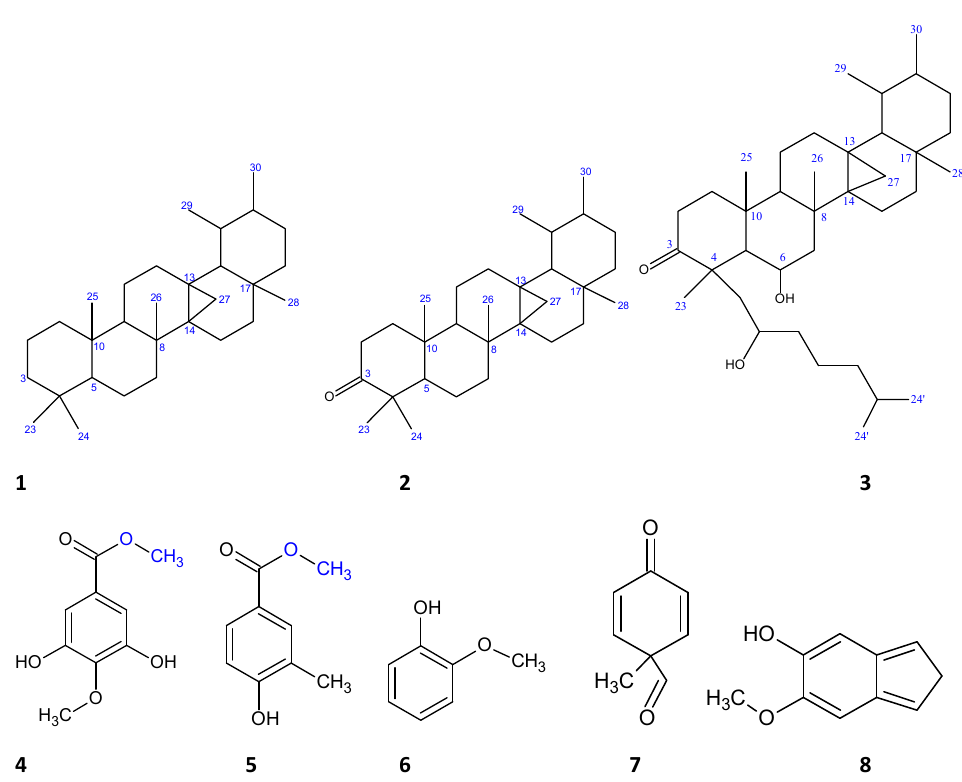
Figure 1. Structures of isolated compounds from the EtOAc fraction of G. braunii leaves.